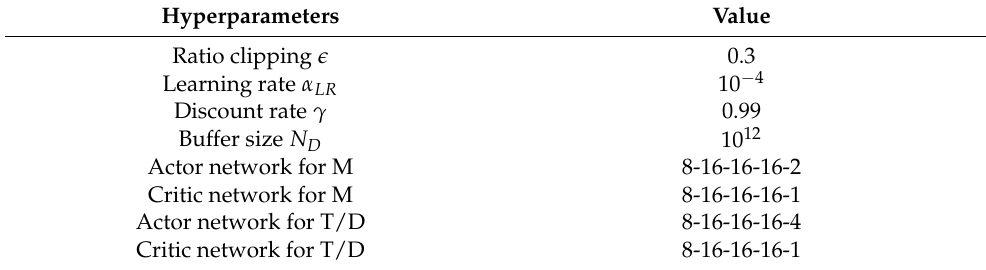
Table 3. Hyperparameters for